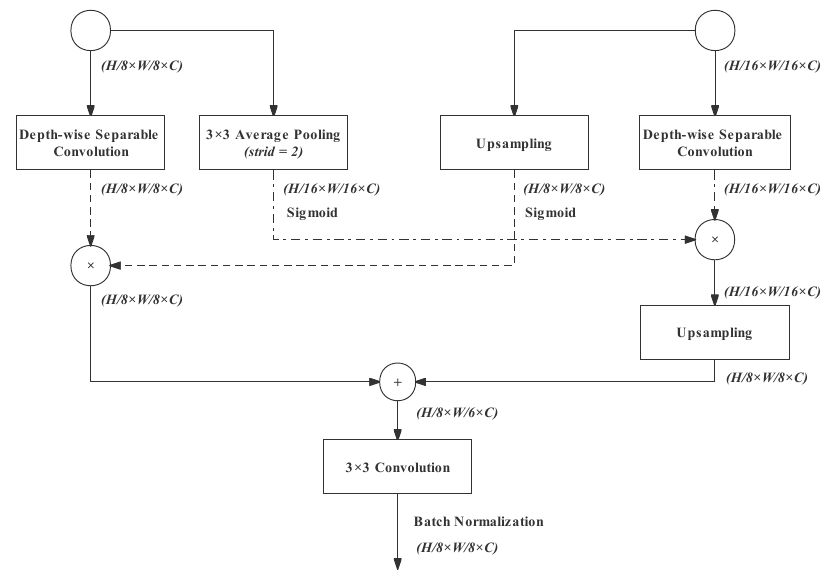
Figure 12. Bilateral guided